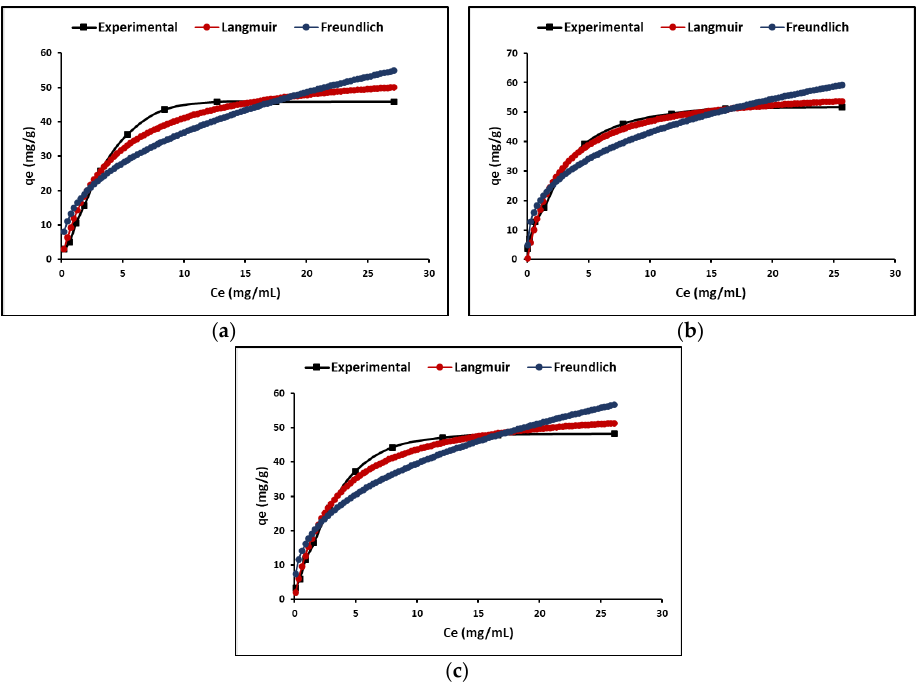
Figure 6. Adsorption isotherms of ( a ) ZTO, ( b ) La/ZTO, and ( c ) Ce/ZTO. The calculated results of the Langmuir and Freundlich isotherm constants are given in Table 2. In this table, the separation factor R L or equilibrium parameter is also reported. Since 0 < R L < 1, it indicates favorable adsorption, while R L > 1 indicates unfavorable adsorption, R L = 0 indicates irreversible adsorption, and R L = 1 indicates linear adsorption [71]; so, in all the cases analyzed here, the cyanide adsorption process is favorable since the calculated R L value was less than one. Table 2. Isotherm parameters for cyanide sorption on nanoparticles.